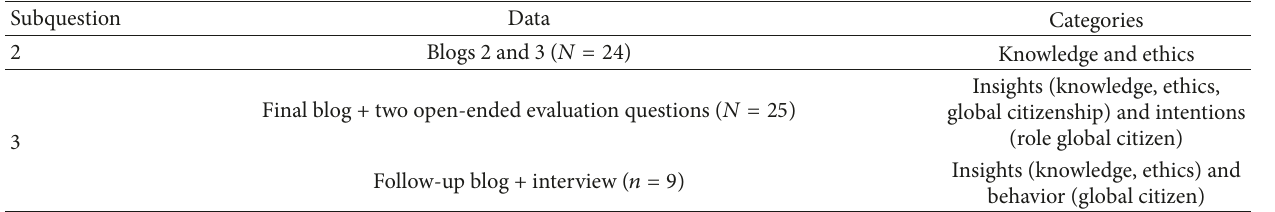
Table 3: Data collection and qualitative data analysis subquestions 2 and 3.